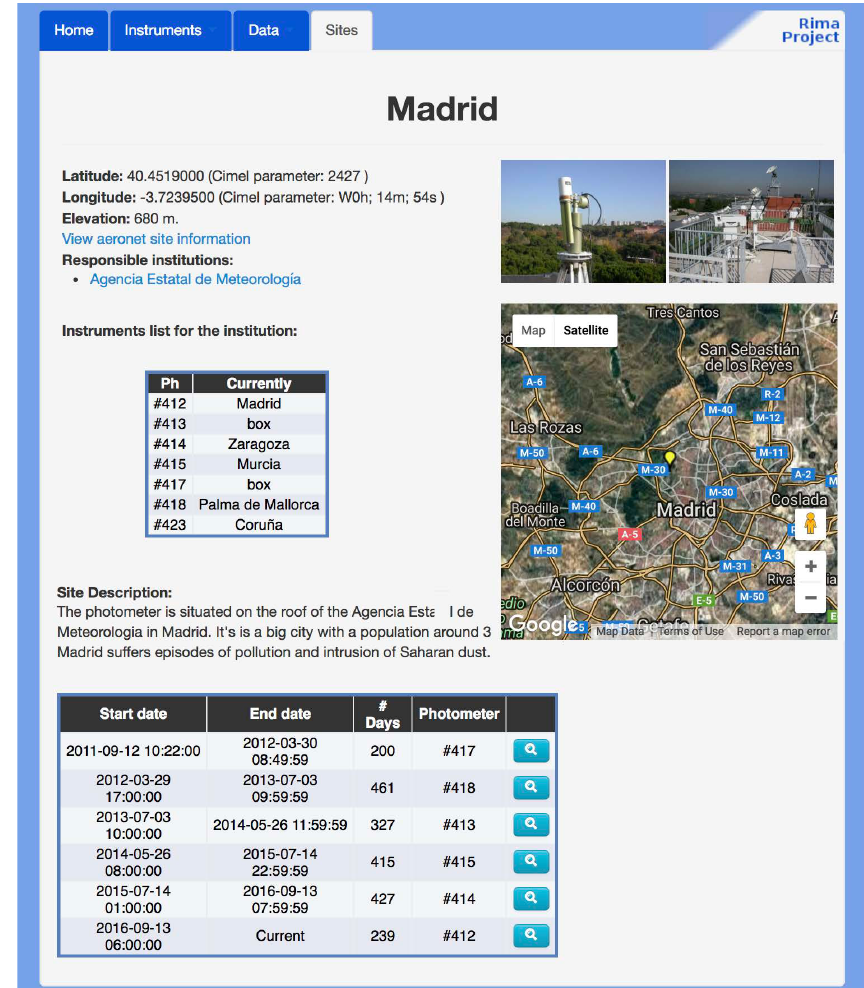
Figure 8. Screenshot of the Madrid site